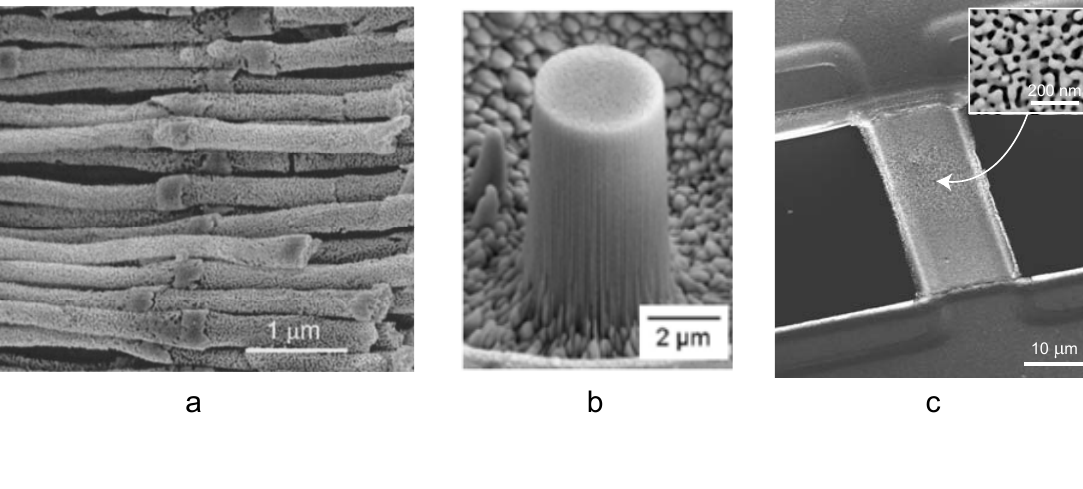
Figure 3. Examples of microfabricated np-Au structures: (a) nanowires produced by electroplating on a porous alumina template [Reproduced with permission from Appl.